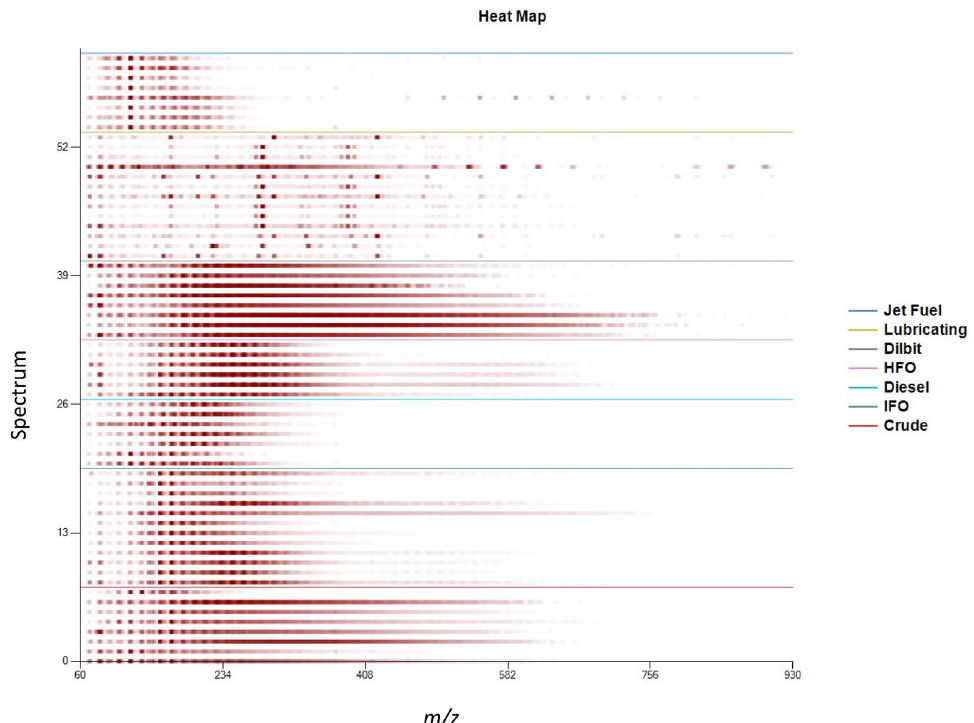
Fig. 2 Positive ion heatmap of different types of oils shows the similarities of chemotypes of oil references within the same type. Heatmap also provides a tool to differentiate oils based on type, though some oil types are difficult to distinguish visually. Oil spectra are organized by type, indicated by the coloured lines above them and the